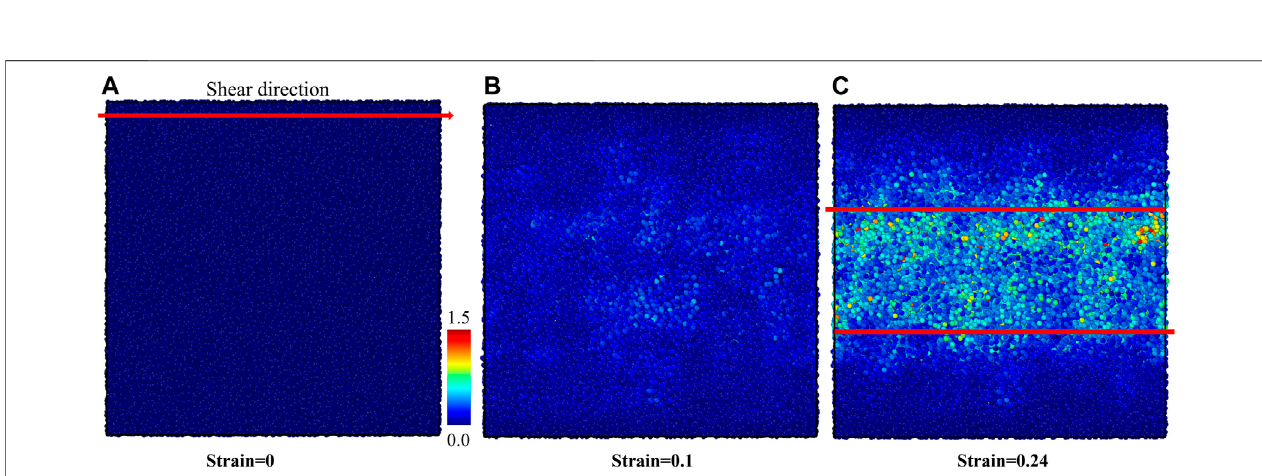
FIGURE9| Theatomicvon-MisesshearstrainmapofL-phaseunderthesheardeformation. (A) Theintactstructure, (B) thestructureat0.1shearstrainbeforethe initiation of shear band, and (C) the structure at 0.24 strain after forming the shear band.